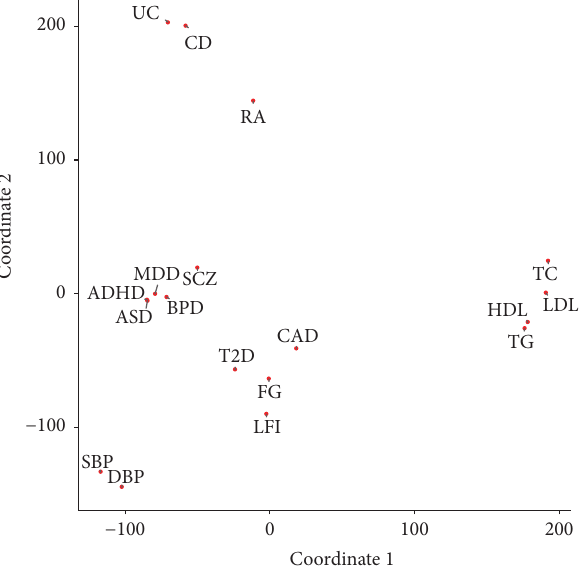
Figure 4: GPA-MDS plot for a joint analysis of genetic studies for 18